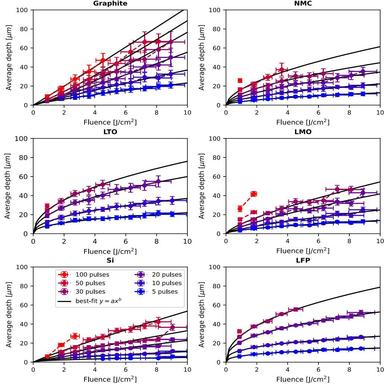
Plots of average pore depth as a function of pulse fluence with best-fit functions of the form = . Best-fit parameters are specified in